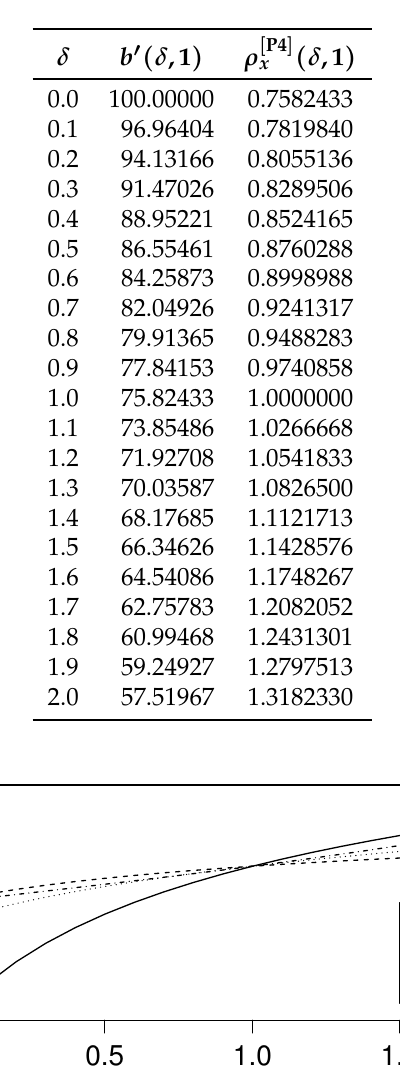
Table 12. Product P4 (enhanced pension); x = 65, b = 100, b (cid:48)(cid:48) = 150.